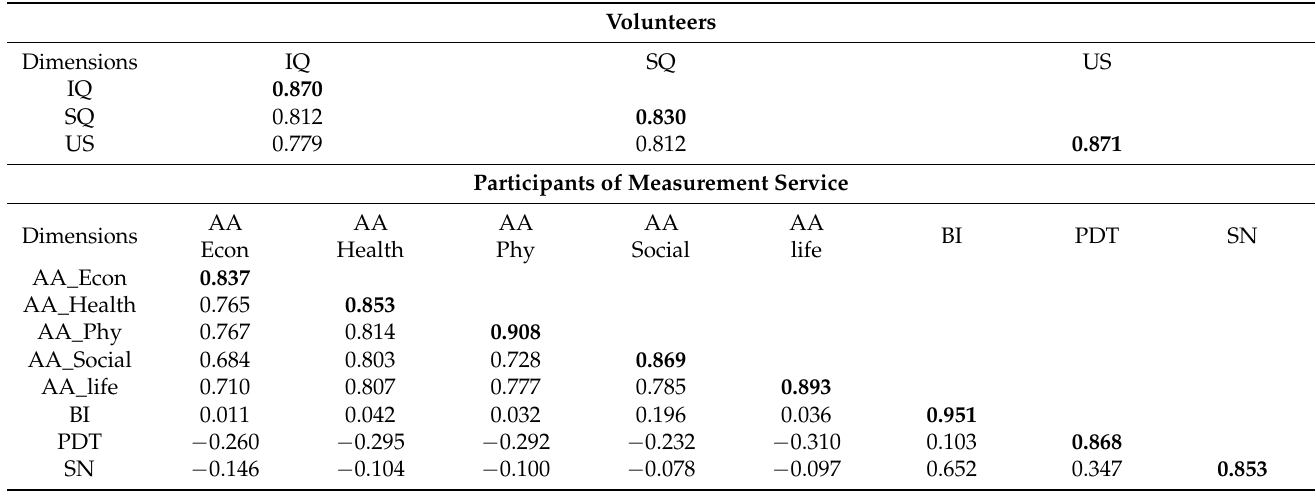
Table 4. Intercorrelations of the latent variables for